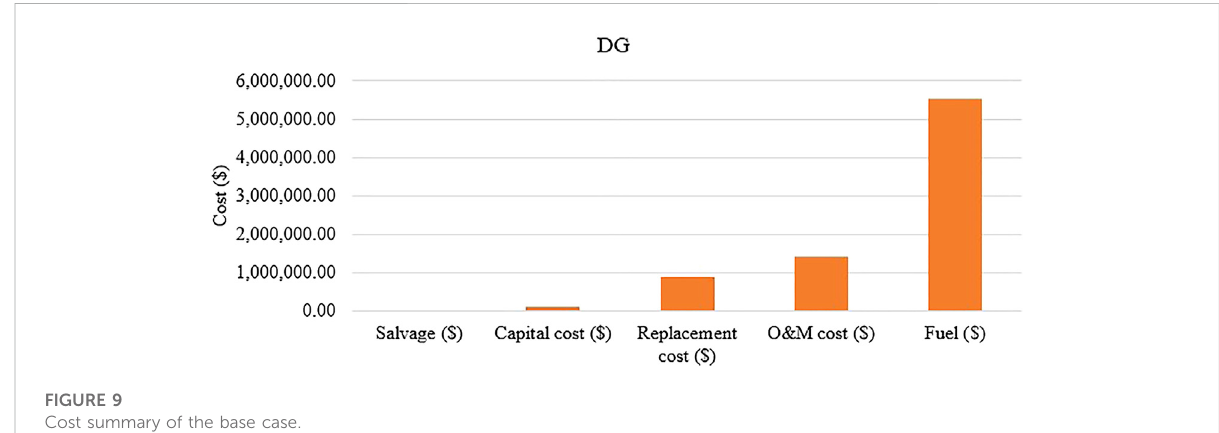
FIGURE 9 Cost summary of the base case.